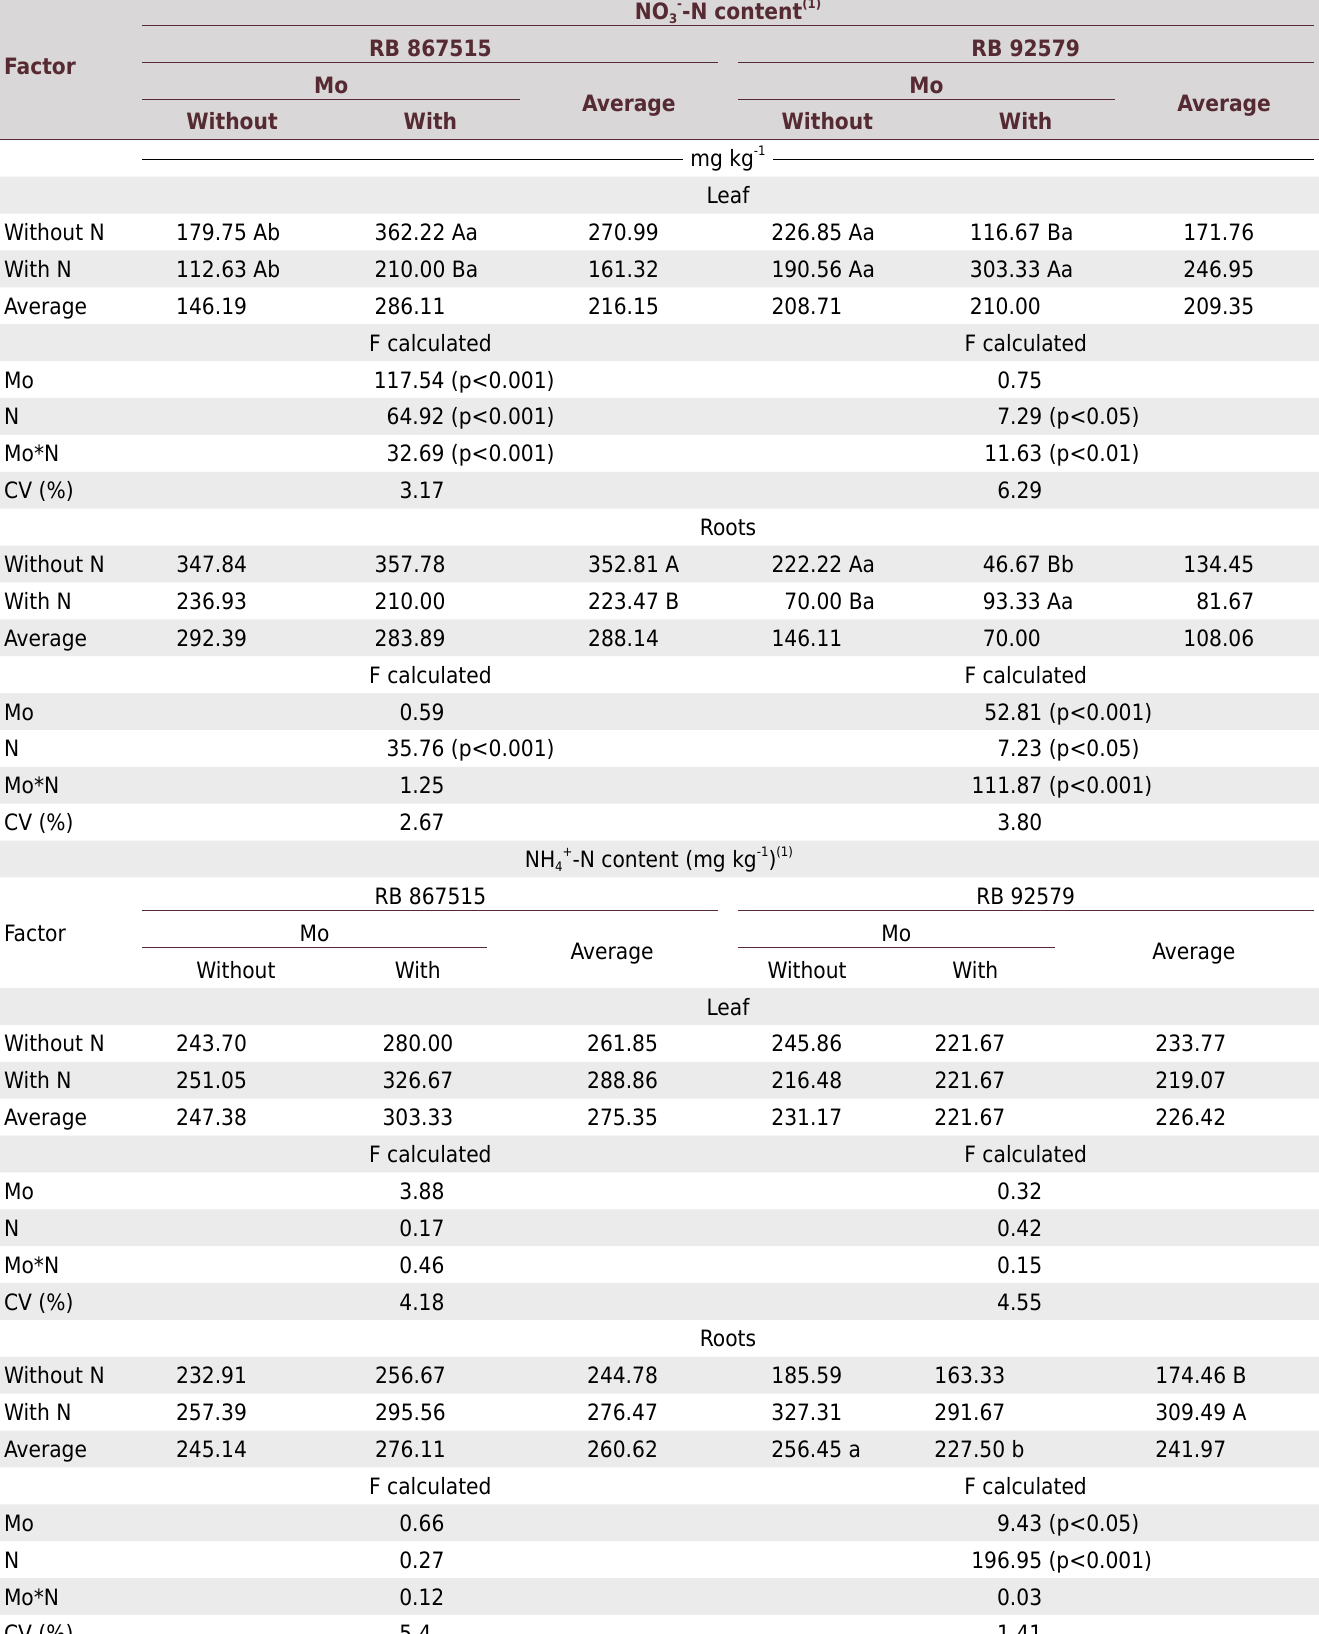
Table 3. Nitrate and NH 4+ -N content in the leaves and roots of the sugarcane varieties RB 867515 and RB 92579, with and without Mo and N